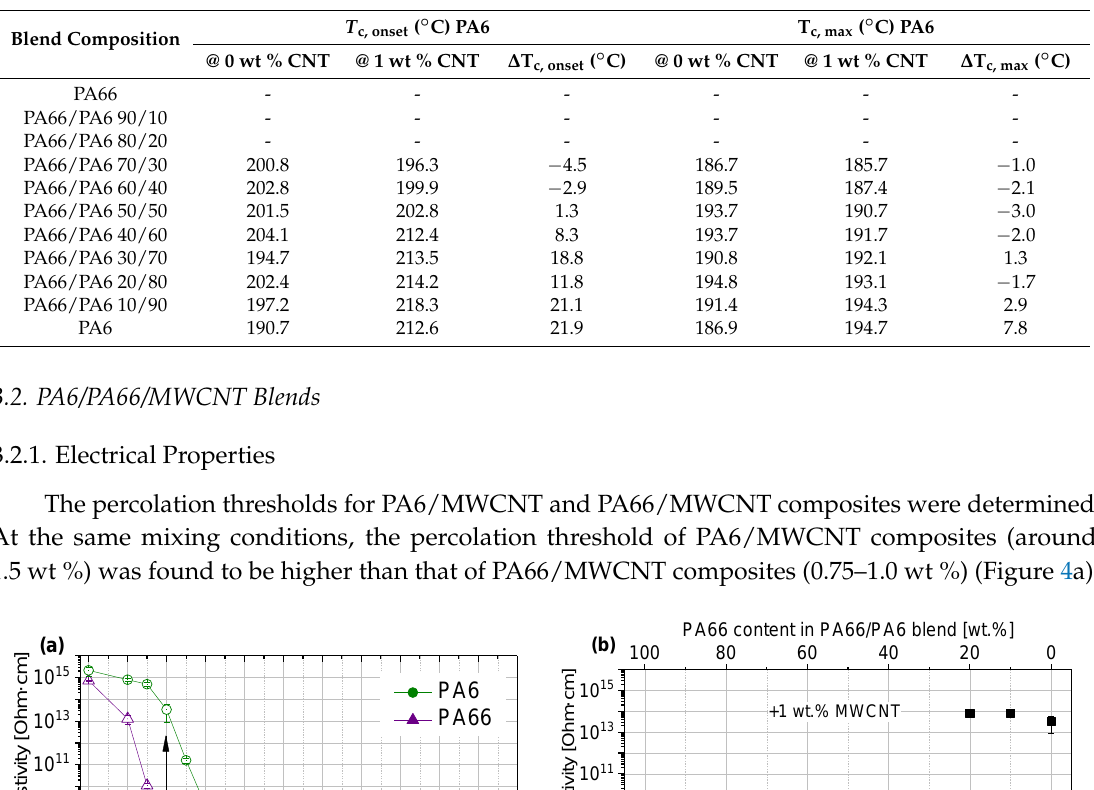
Table 2. Crystallization temperatures T c, onset and T c,max of PA66/PA6 blends filled with 0 or 1 wt % MWCNT and their differences ( ∆ T c, onset , ∆ T c, max ) regarding PA6 crystallization.